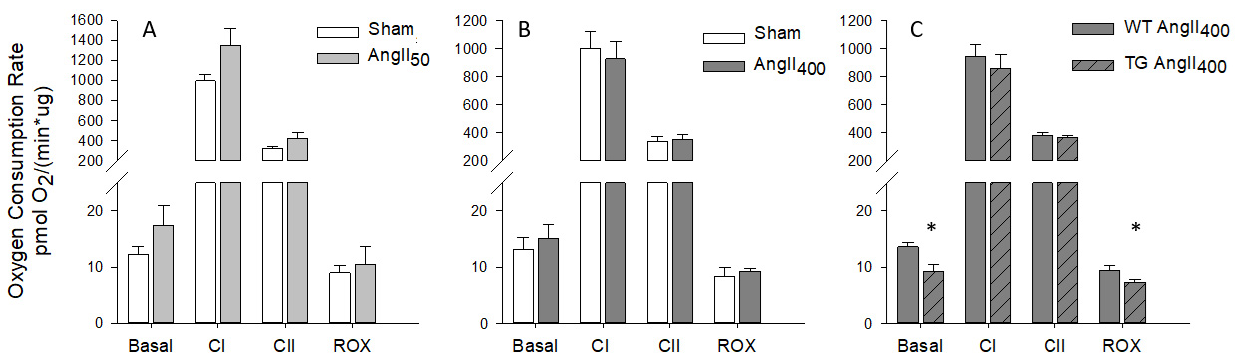
Figure 3. Oxygen consumption rate measured in homogenate from frozen left ventricular heart tissue from C57BL/6J, wild-type (WT), and cardiomyocyte specific NOX2 transgenic (TG) mice treated for two weeks with micro-osmotic pumps containing either saline (sham), 50 or 400 ng/kg/min angiotensin II (AngII 50 and AngII 400 ). ( A ) Sham and AngII 50 . ( B ) Sham and AngII 400 . ( C ) WT AngII 400 and TG AngII 400 . Basal, homogenate with cytochrome C; Complex I (CI), homogenate and NADH; Complex II (CII) is homogenate with rotenone (CI-blocker) and succinate; Residual Oxygen consumption (ROX), homogenate with malonate (CII-blocker) and antimycin A (CIII-blocker). Data are means ± SEM. * p < 0.05 vs. WT.